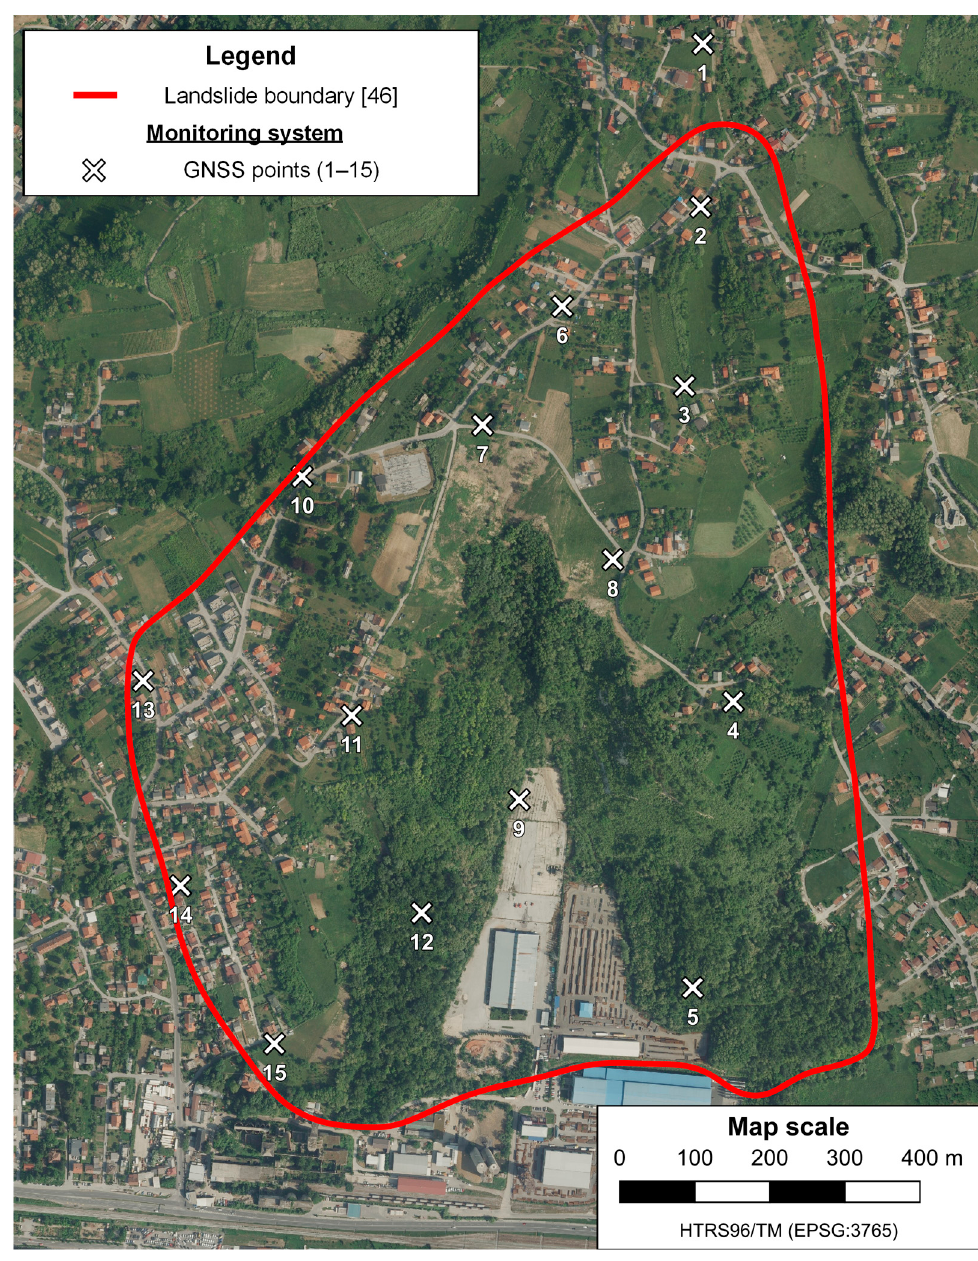
Figure 5. Locations of the permanently established GNSS sensors on the landslide for kinematics monitoring in real-time.